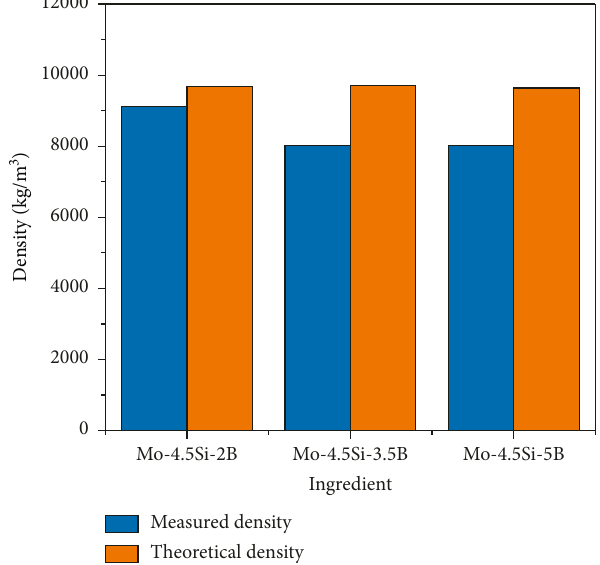
Figure 4: Density under different ingredients.